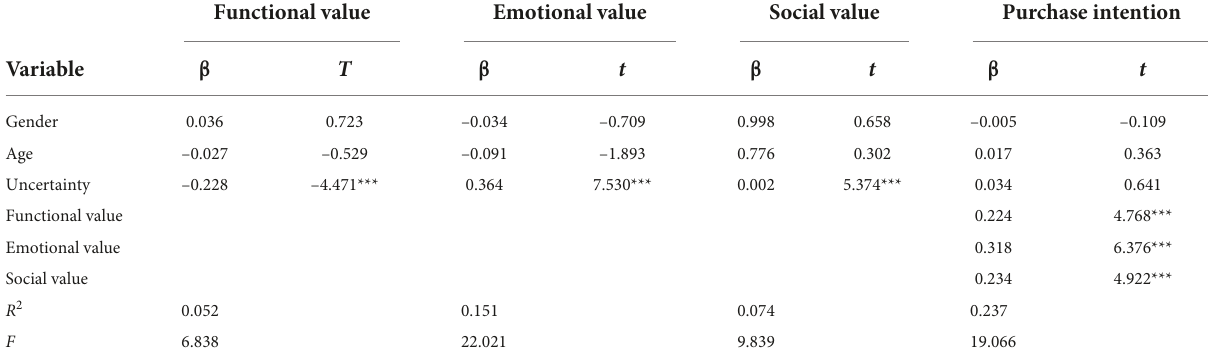
TABLE 5 Mediating model test of perceived